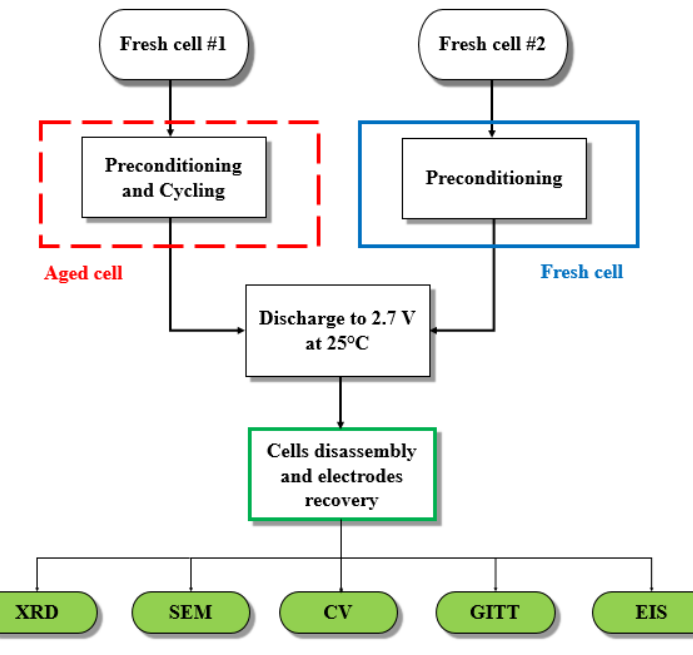
Figure 1. Flow diagram of battery cells and electrodes experimental